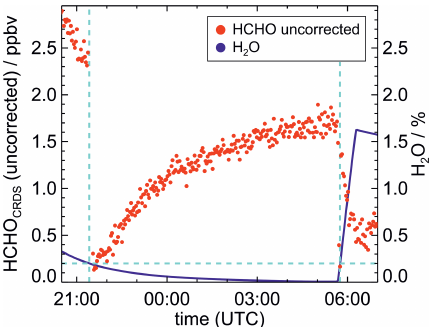
Figure 3. Time series of HCHO measurements by the CRDS in- strument without offset correction and with varying water mixing ratios in the chamber. Measurements by the Hantzsch instrument (not shown) indicated that mixing ratios were much smaller than the Picarro measurements, with values that continuously decreased from 200pptv to zero until midnight due to the flushing of the cham- ber with zero air. They also remained close to zero during the hu- midification starting at 05:45UTC in the morning. In contrast, the uncorrected CRDS measurements showed fast changes when the water vapour mixing ratio became lower or higher than 0.2% (blue dashed line). They also showed slow changes that (anti)correlated with the water vapour mixing ratios. Before humidification, an off- set value of 1.7ppbv was measured in dry air.